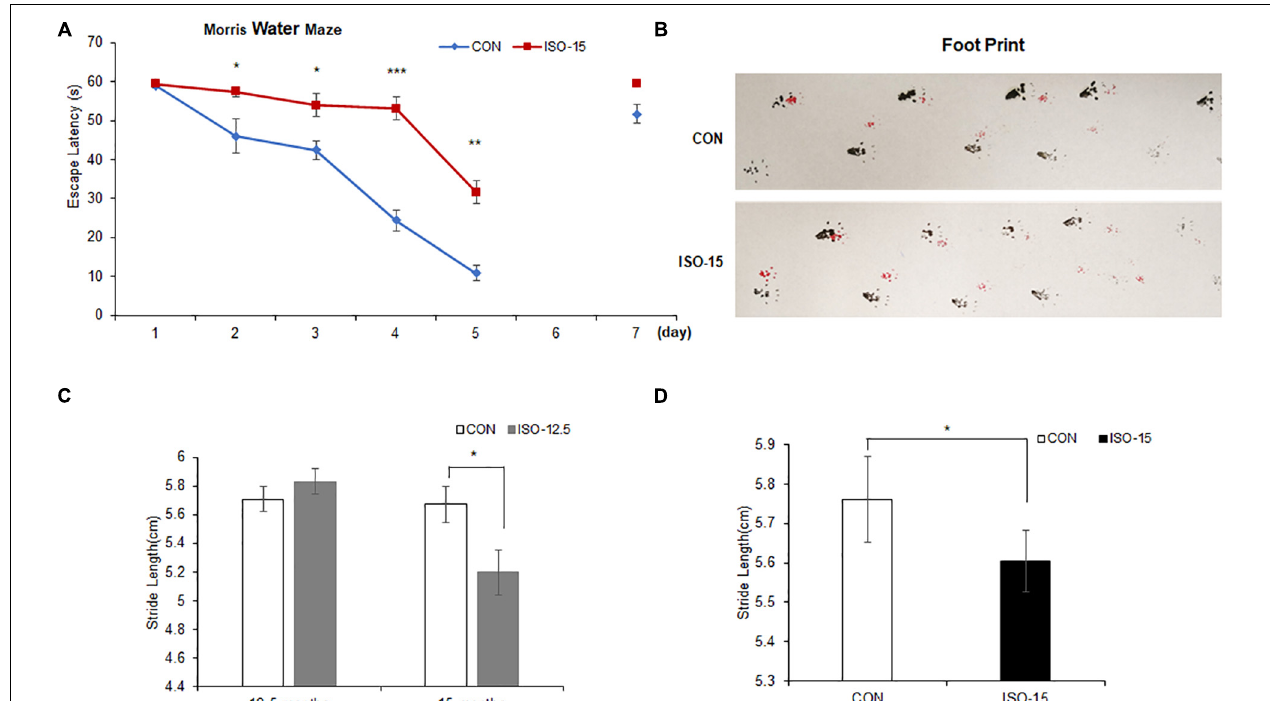
FIGURE 1 | The spatial learning cognitive impairment and motor dysfunction were reduced in isoflurane-exposed aged mice: (A) 15-month-old mice exposed to isoflurane displayed prolonged escape latency compared with the CON group from the second test day to the fifth test day, while 1 day no test interval later, the difference between the two groups was not significant ( n = 10, * p < 0.05, ** p < 0.01, *** p < 0.001). (B) The footprint of mice in different groups. (C) At the age of 12.5 months, there were no significant differences in the gait function between the two groups. However, until these mice were at the age of 15 months, the stride length of those mice exposed to 2% isoflurane was significantly lower than that in the CON group ( n = 10, * p < 0.05). (D) The stride length of 15-month-old mice exposed to 2% isoflurane was significantly lower than that in the CON group ( n = 10, * p < 0.05).